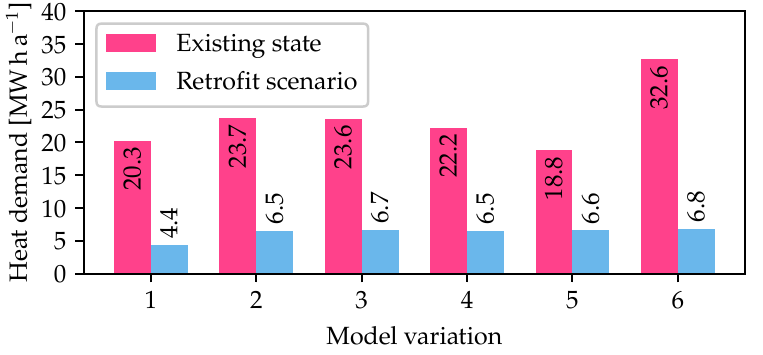
Figure 7. Simulated heat demand of the case study building in its existing state and in retrofit scenarios for all six model variations presented in Section